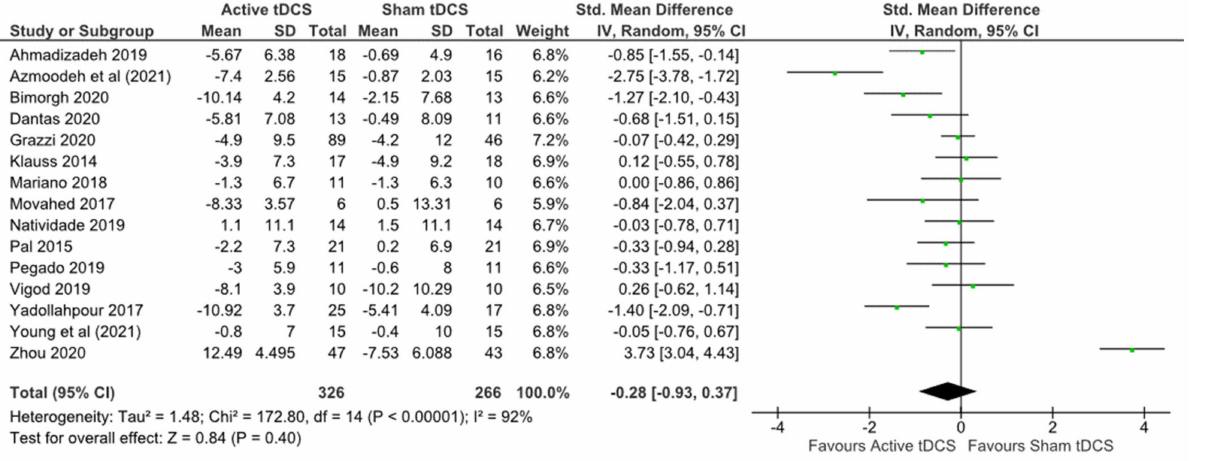
Figure 5. Forest plot